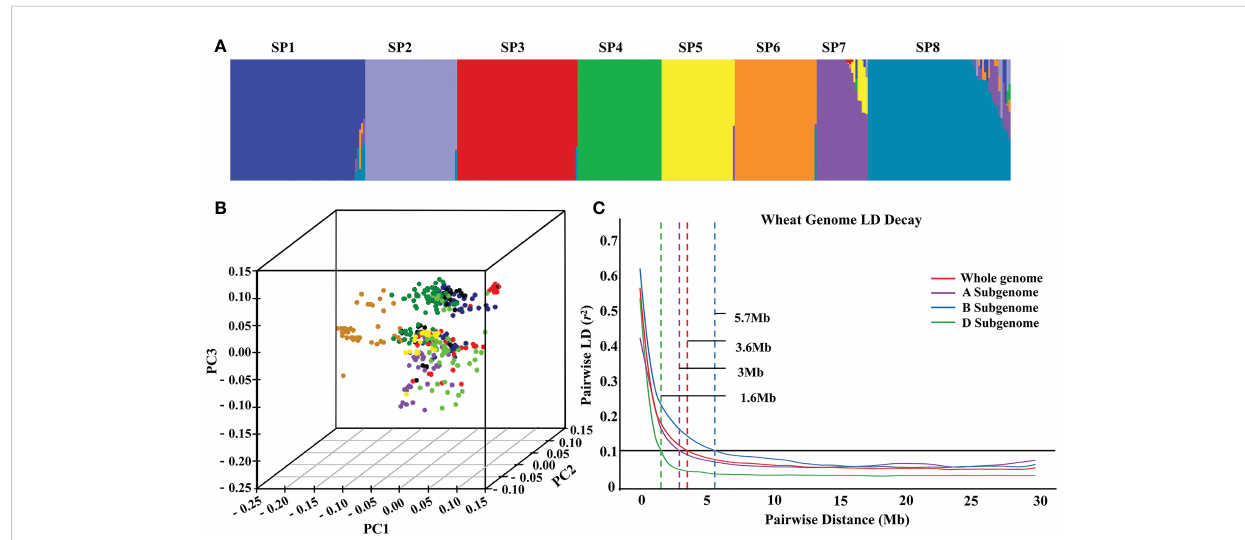
FIGURE 3 The population structure and linkage disequilibrium of 382 wheat accessions. Subpopulations inferred by K-mean structure analysis (A) . Principal component analysis of all wheat accessions (B) . LD decay (C) over different genetic distances (Mb) for A, B and D subgenomes and whole genome in the wheat panel ( r 2 =